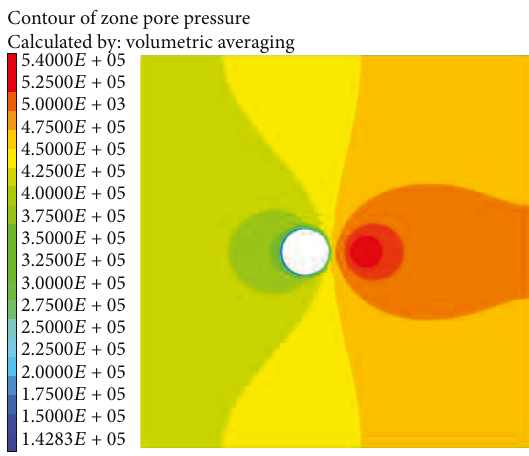
Figure 4: Finite element model of the circular karst tunnel.